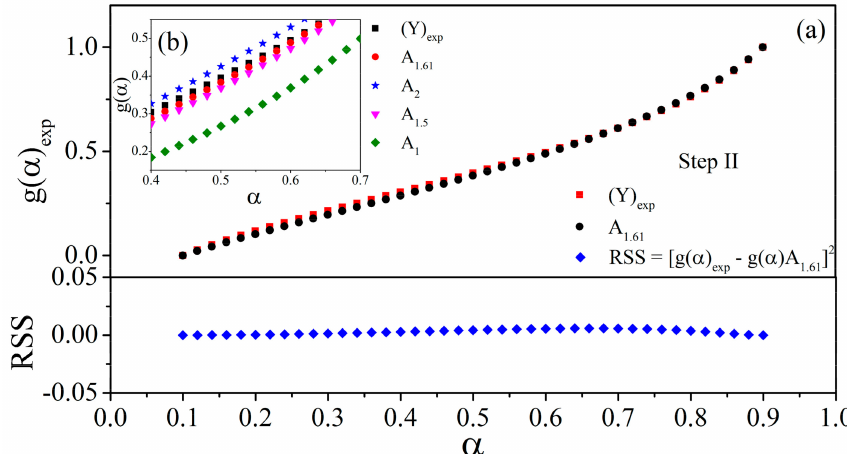
Figure 10. The experimental and the theoretical plots ( a , b ) of the explored g( α ) versus α curves using the reaction models for the second